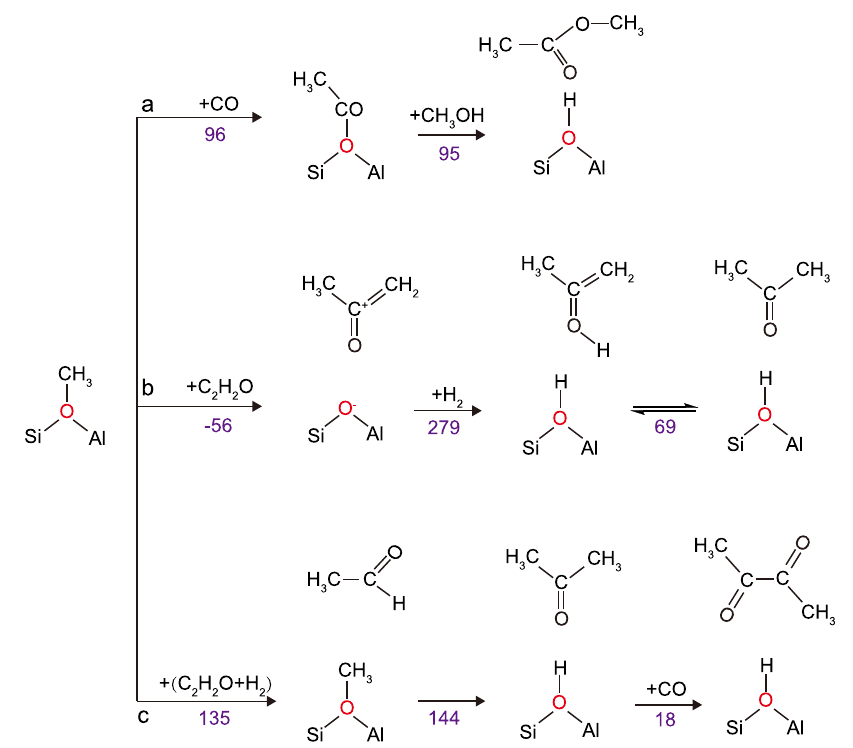
Fig. 8 Illustration of proposed formation routes of carbonylated intermediates. a The formation of surface acetate and methyl acetate from surface- methoxy species and two acetone production routes: b by direct conversion of ketene via keto-enol tautomerization as well as c initial hydrogenation of ketene to acetaldehyde and diacetyl from acetone, conducted on FER models, with reaction energies (in violet) presented as -(E r ) in kJ/mol.